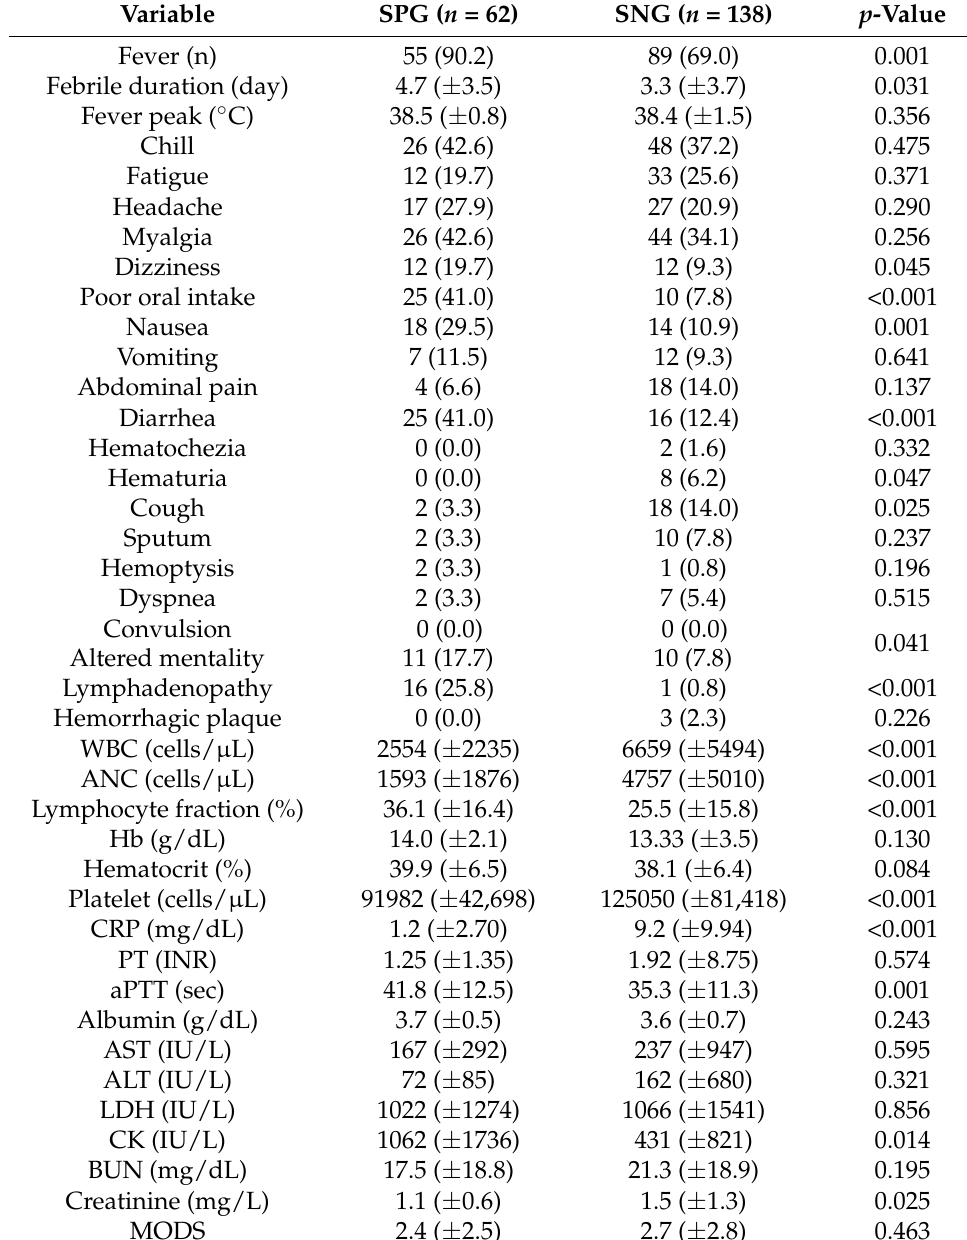
Table 2. Clinical symptoms and laboratory findings at initial presentation for patients with positive (SPG) and negative (SNG) results severe fever with thrombocytopenia syndrome using